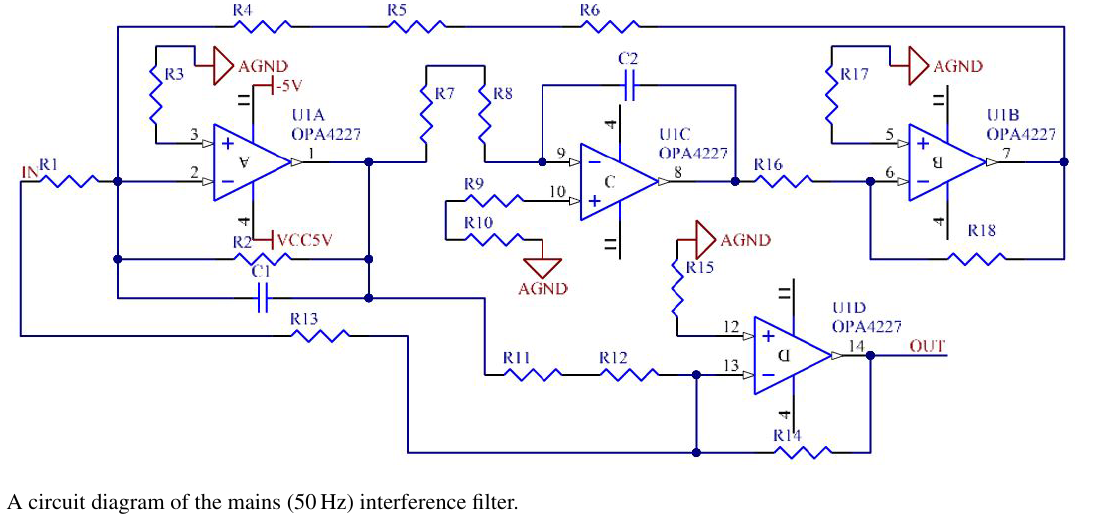
Figure 3. A circuit diagram of the mains (50Hz) interference filter.